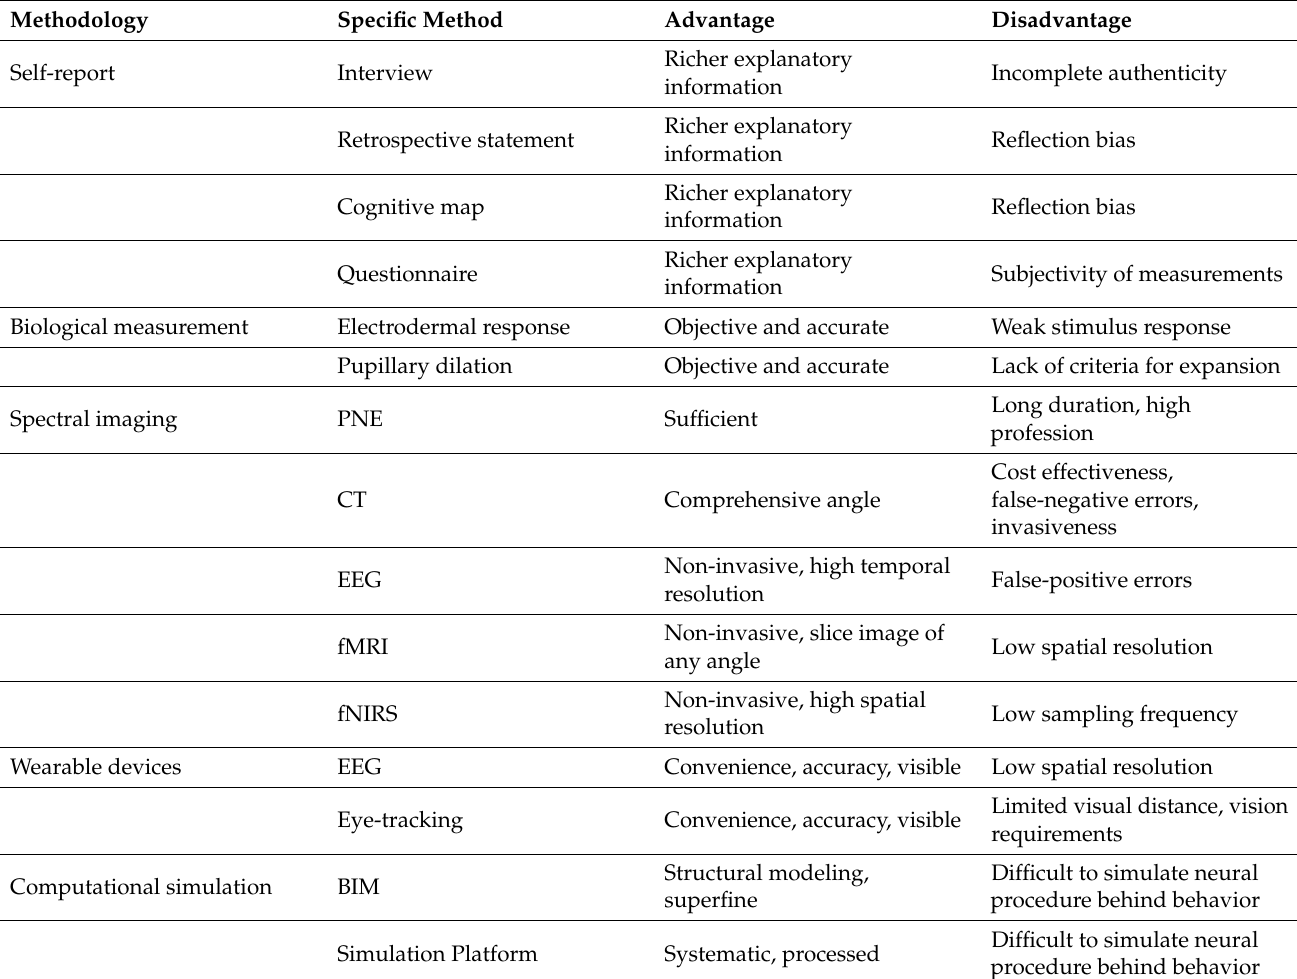
Table 1. Comparison of neuropsychological